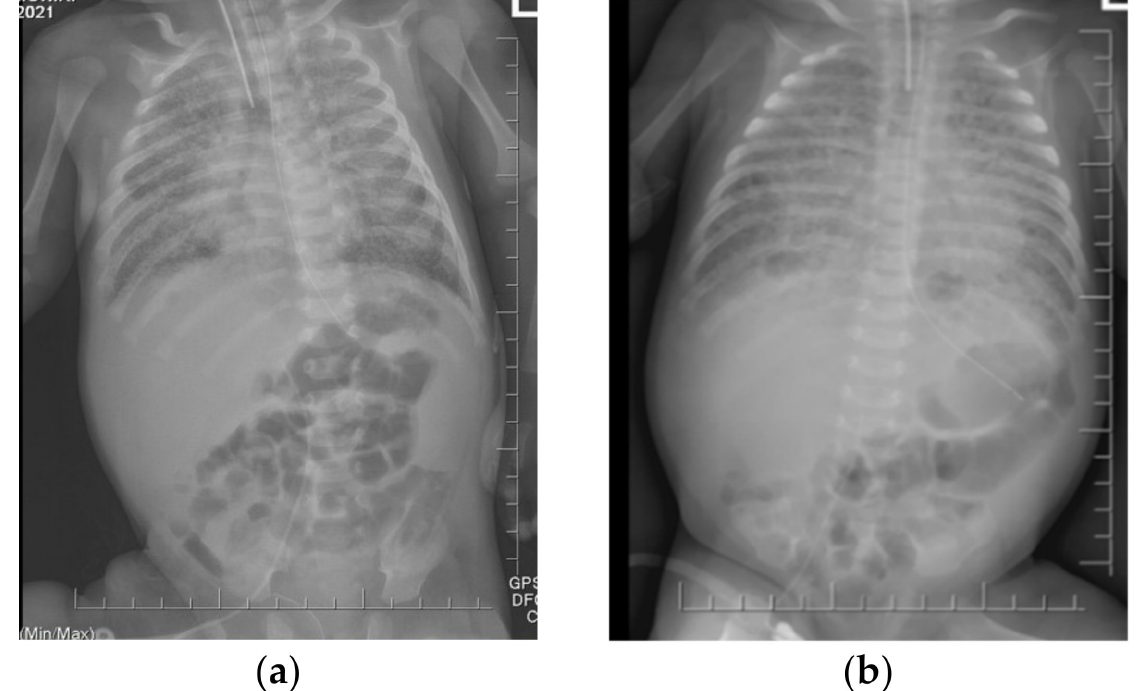
Figure 2. The chest X-rays revealed diffuse opacification of both lungs with air bronchograms. No improvement has been observed during one month. ( a ) 54th day of life ( b ) 85th day of